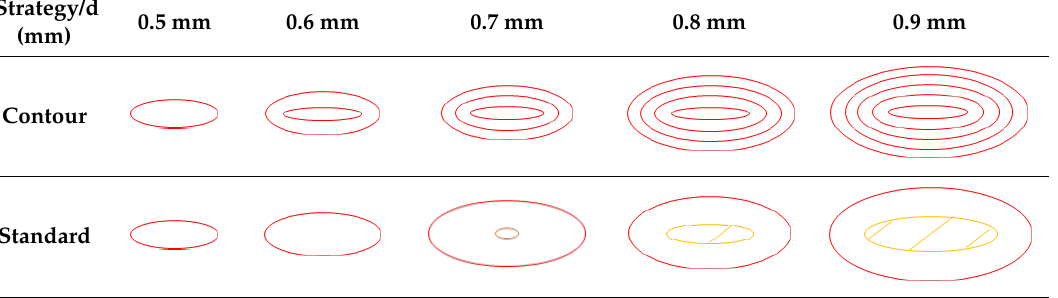
Table 1. Laser strategies of the strut with inclination of 35.26° (orientation in body centered cubic (BBC) lattice structure).